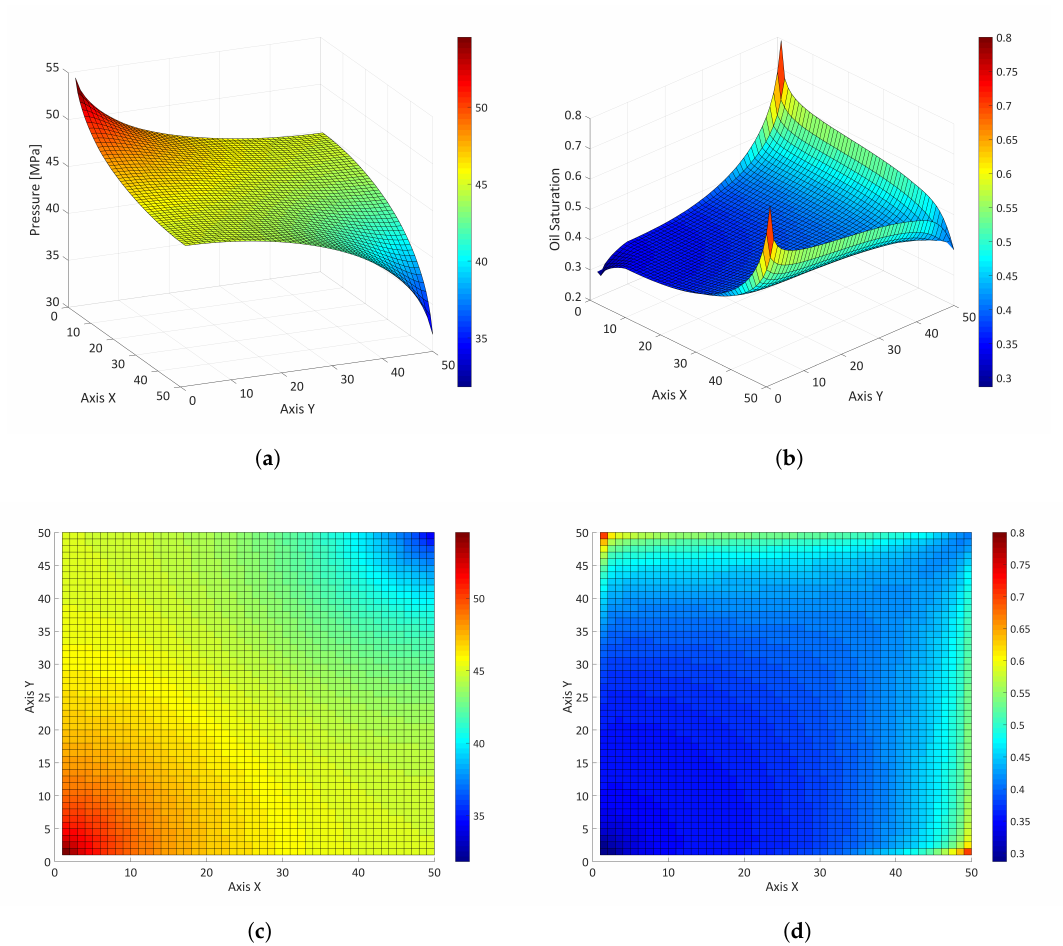
Figure 8. Pressure (in MPa) (left— a and c ) and oil saturation (right— b and d ) in a non-iterative secondary recovery process after 5000 days, for the model with 50